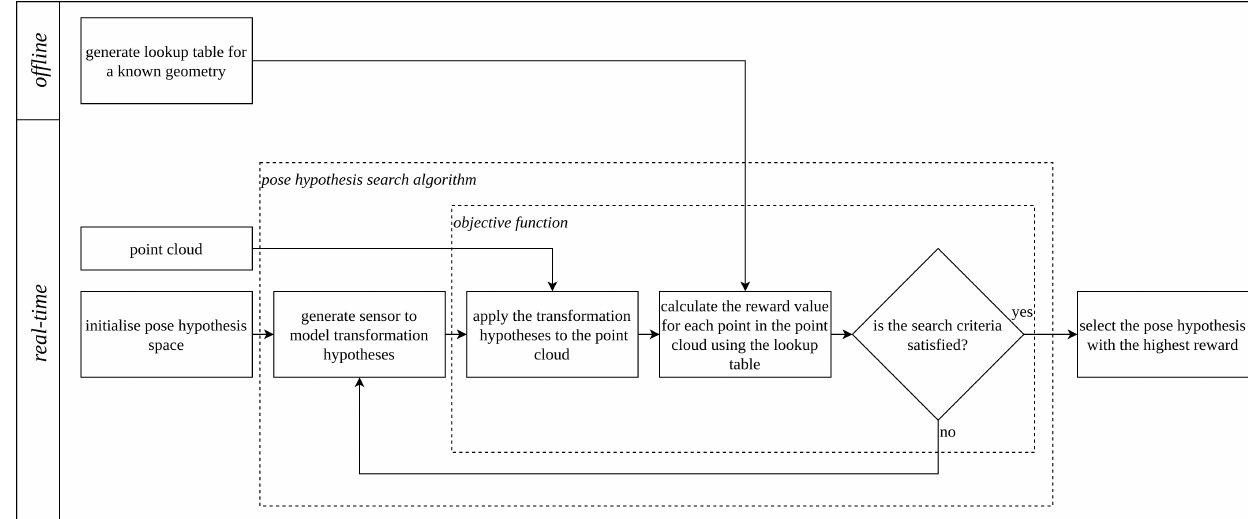
Figure 3. A flowchart summarising the entire process. The search algorithm uses the objective function to determine the best pose estimate. The contribution of this paper is the PLuM objective function. This can be used with a search algorithm of choice. Search algorithms have a termination condition, commonly a change in gradient for gradient-based solvers or the number of iterations for a particle